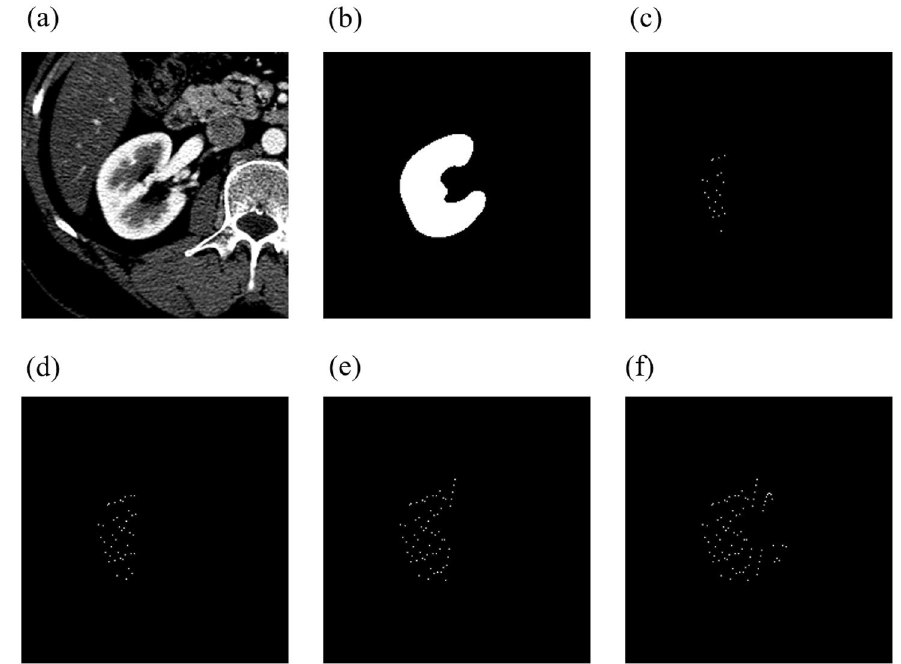
Figure 6. The process of generating points for the class OC. ( a ) shows a fragment of the original CT image. ( b ) shows a mask with a kidney labelled by an expert. ( c – f ) shows the point generation process.